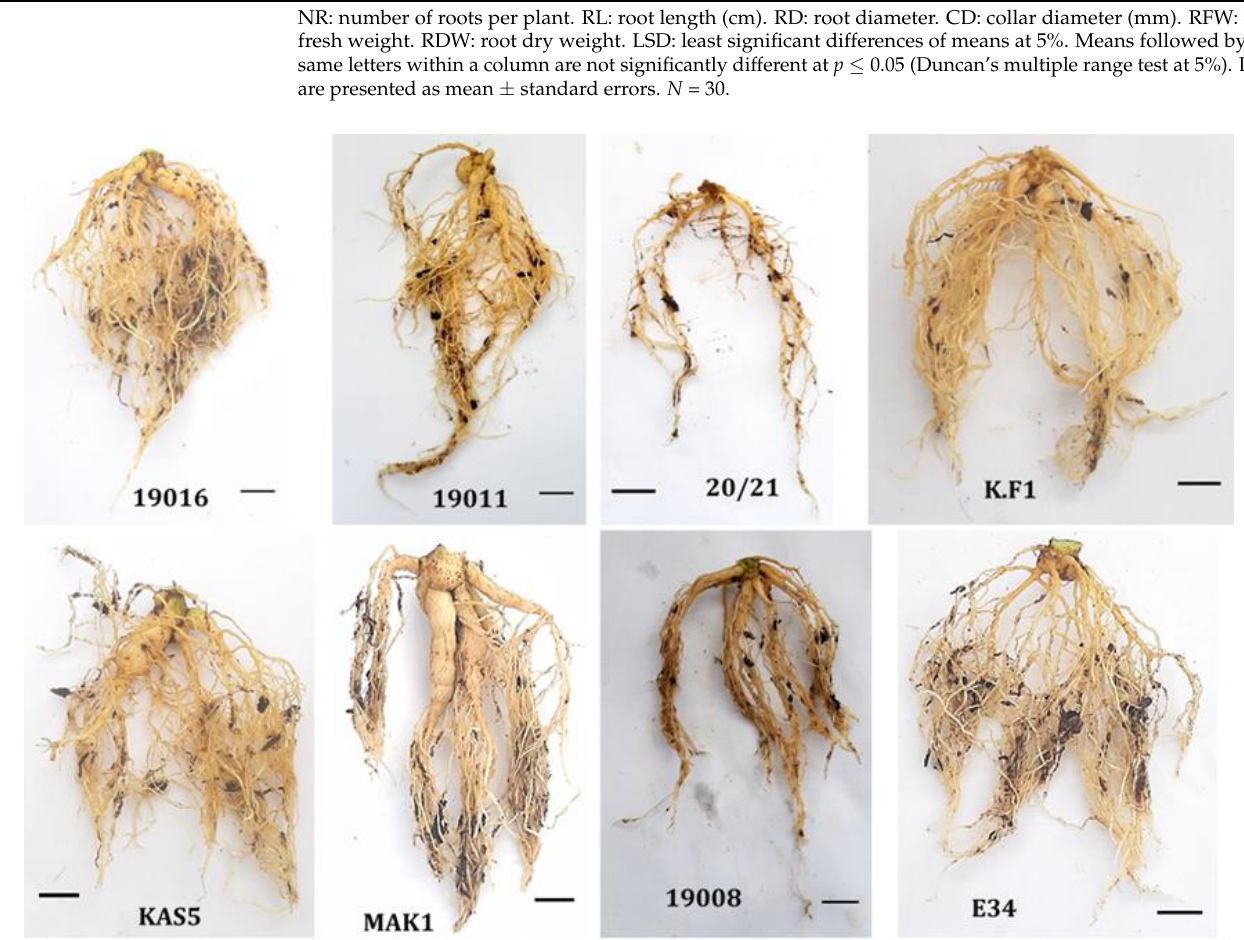
Figure 2. Morphological diversity of the root system of M. volkensii clones after two months of accli- matization under greenhouse conditions (scale bar = 1 cm). 3.3. Quality Indexes There were highly significant ( p <0.001) differences for SQ, DQI, and S:R among M. volkensii clones (Table 3). Sturdiness quotient ranged from 1.33 for clone 19003 to 2.74 for 19008. All clones had an SQ below the threshold of 6, which is recommended for robust young trees. The highest S:R ratio values of 7.58 were observed for 19015, while the lowest values of 2.35 and 3.45 were recorded for MAK1 and 19011. Since almost all evaluated clones had an S:R higher than the recommended value (≤1), even MAK1, it can be con- cluded that all acclimatized plants developed a disproportionately light root system in the pots. DQI index varied significantly among clones. The DQI ranged between 0.05 for 20/21 and 0.48 for MAK1. Seven clones out of thirteen had the average recommended value of ≥0.2. The plant volume significantly varied among clones. Giant plants were observed in clones MAK1 with a mean shoot volume of 171.3, followed by clone 19007 (120.2), 19016 (119.3), K.F1 (113.1), and 19011, respectively. The plants with smaller volumes were rec- orded from 20/21 (41.6), 19003 (41.9), 19015 (47.7), and E34 (42.8), respectively. Clone rank- ing using plant volume index was comparable with the Dickson quality index ranking.